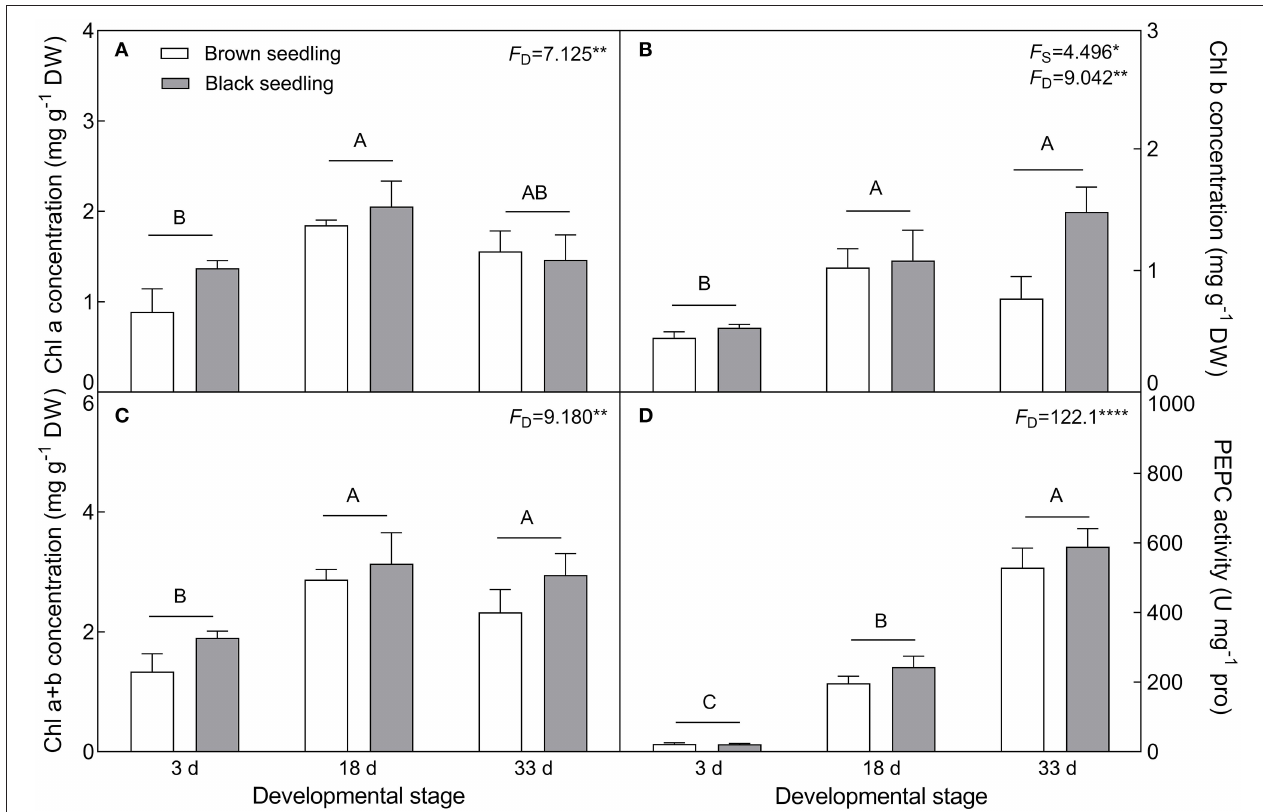
FIGURE 8 | Changes in the concentration of chlorophyll and activity of PEPC during seedling development. (A) Chl a, (B) Chl b, (C) total Chl, and (D) PEPC. 3 d, 18 d, 33 d represent 3, 18, and 33 days after seedling emergence, respectively. F -values are given when significance levels are reached (the subscript “D” represents “development”; “S”, “seed type”; * P < 0.05; ** P < 0.01; **** P < 0.0001). Bars with different uppercase letters indicate significant differences ( P < 0.05) according to Tukey’s test. Values are means ± SE of four